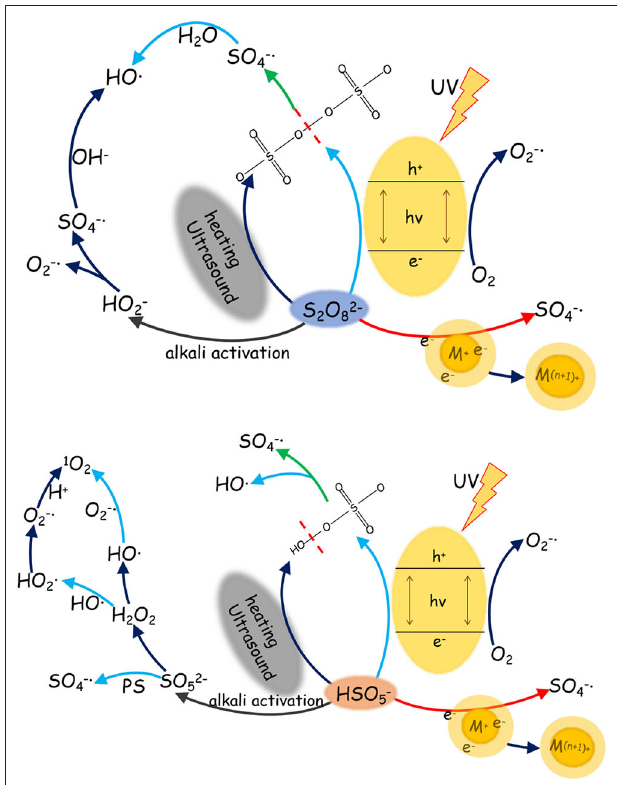
FIGURE 1 | Generation of sulfate radical via persulfate/peroxymonosulfate (PS/PMS) activation under different reaction conditions.